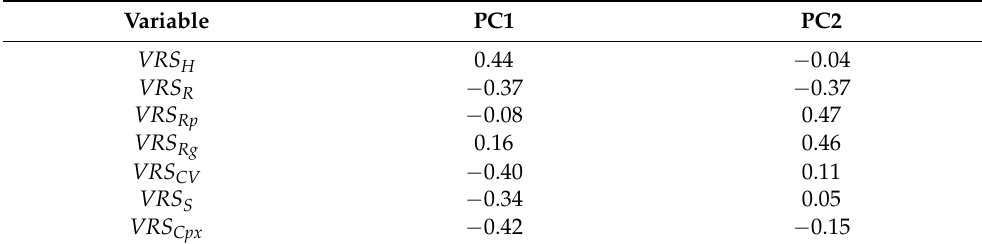
Table 1. The results of the PCA on the VRS of the seven visual texture attributes: the first two principal component coefficients, PC1 and PC2.